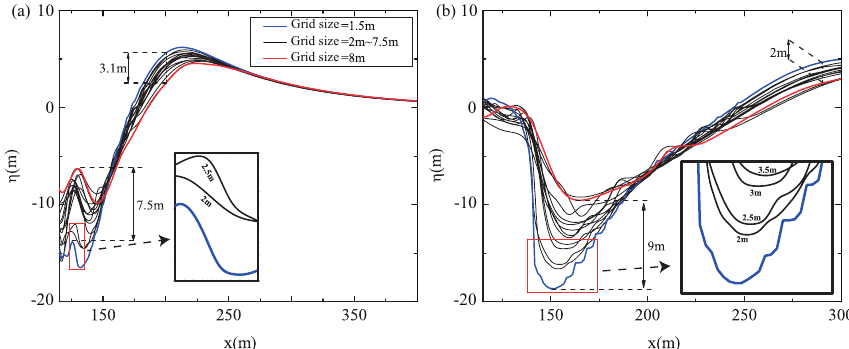
Figure 6. Calculation results of uniform mesh of different sizes in the near field: ( a ) t = 5 s; ( b ) t = 10 s. After the leading wave is formed, the landslide stops moving and the resulting swell begins to propagate forward. It can be seen from Figure 7 that, after the wave enters the propagation stage, the wave calculated difference of the PF is smaller than the NF under different mesh sizes. Whether or not the peak or trough calculated difference is within 2 m, the relative error is less than 25%.